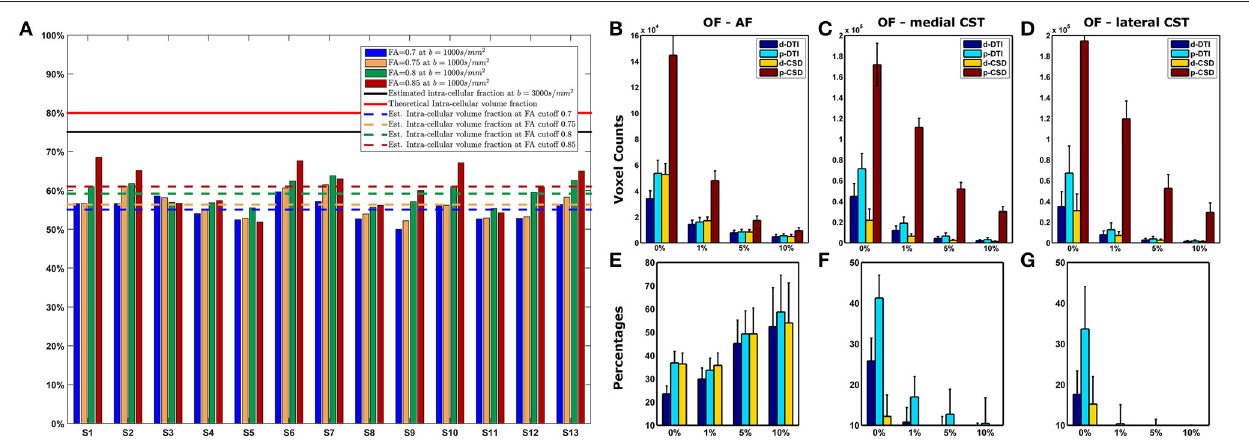
FIGURE 1 | Intra-axonal volume fraction and OF analysis. (A) Intra-axonal volume fraction estimated with a b -value of 1,000 s/mm 2 . Theoretic limit and average estimates obtained on datasets with b -values of 3,000 s/mm 2 are shown (continuous lines); mean estimates averaged over all subjects in this study are shown with dashed lines, one for each FA cutoff. (B–E) Overlap Fraction analysis. Voxels count for each method and density cutoff is shown for AF (B) , medial CST (C) , and lateral CST (D) portion reconstructions; data reported are averaged over subjects and between left and right hemispheres. At the same time, OF analysis ( E–G , based on probabilistic CSD reconstruction used as reference (brown bar), shows how both deterministic (blue) and probabilistic (cyan) DTI cause notable underestimation either for AF (E) , medial (F) , and lateral (G) CST portions. Whiskers represent one standard deviation. OF, Overlapping fraction; AF, Arcuate Fasciculus; CST, Corticospinal